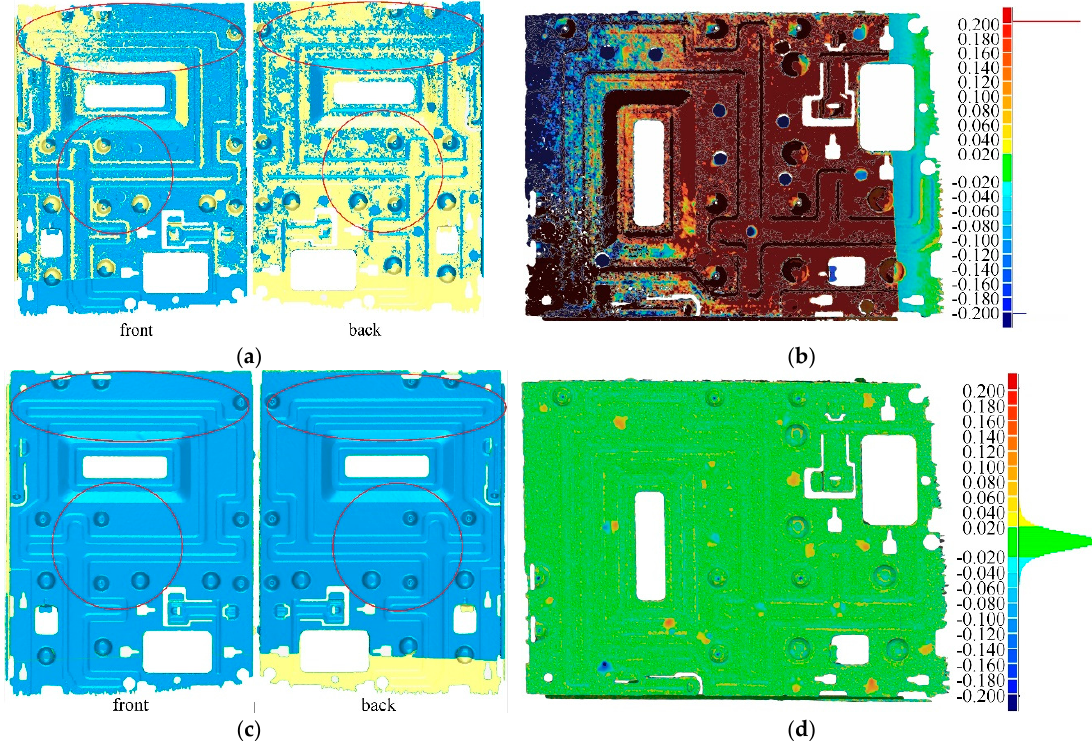
Figure 4. Optimization of the 3D surface reconstruction of a sheet metal part; ( a ) results of Tubi´c et al. [6]; ( b ) deviation colormap between Tubi´c’s 3D model and the computer-aided design (CAD) model; ( c ) results of the proposed method; ( d ) deviation colormap of the proposed method.